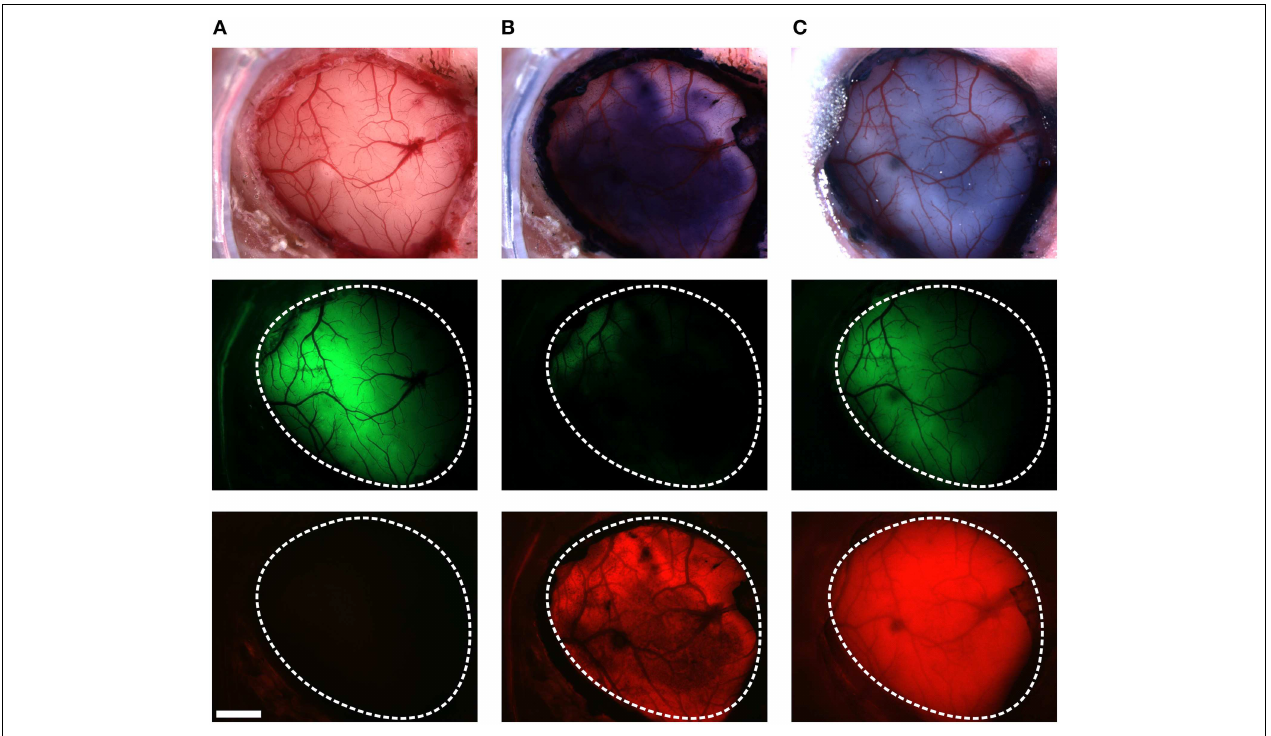
FIGURE 2 | Staining VSFP2.3-expressing cortex with RH1691. Brightfield images (top row), Citrine fluorescence (middle row) and red fluorescence (bottom row), before (A) , after staining with RH1691 ( B ; 15 min after washing with dye free solution) and the